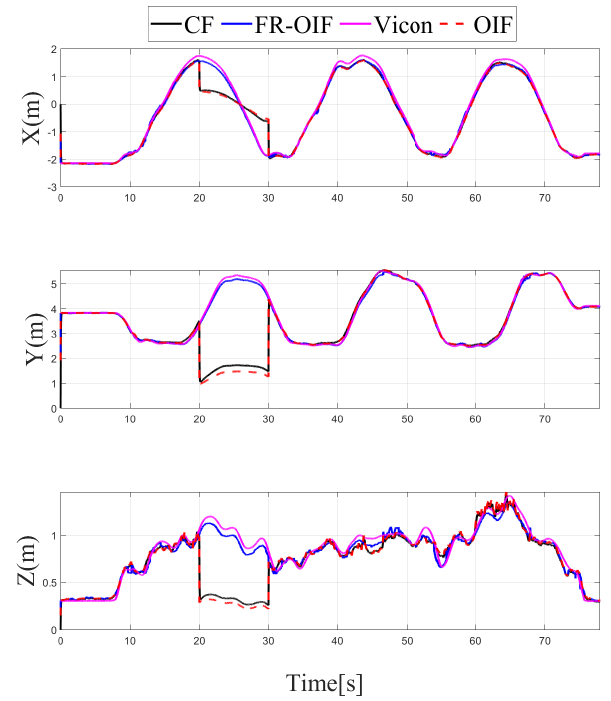
Figure 11. Case-4: Estimated positions along ‘X-Y-Z’ components obtained from intermediate nodes ( A , . . . , G ) and FR-OIF, compared with CF, OIF and the ground truth. The evaluation is carried out in presence of simultaneous temporal fault appearing from UWB and LIO during (20–30) s. Except the fused position obtained from FR-OIF all the estimated positions deviated in presence of faulty